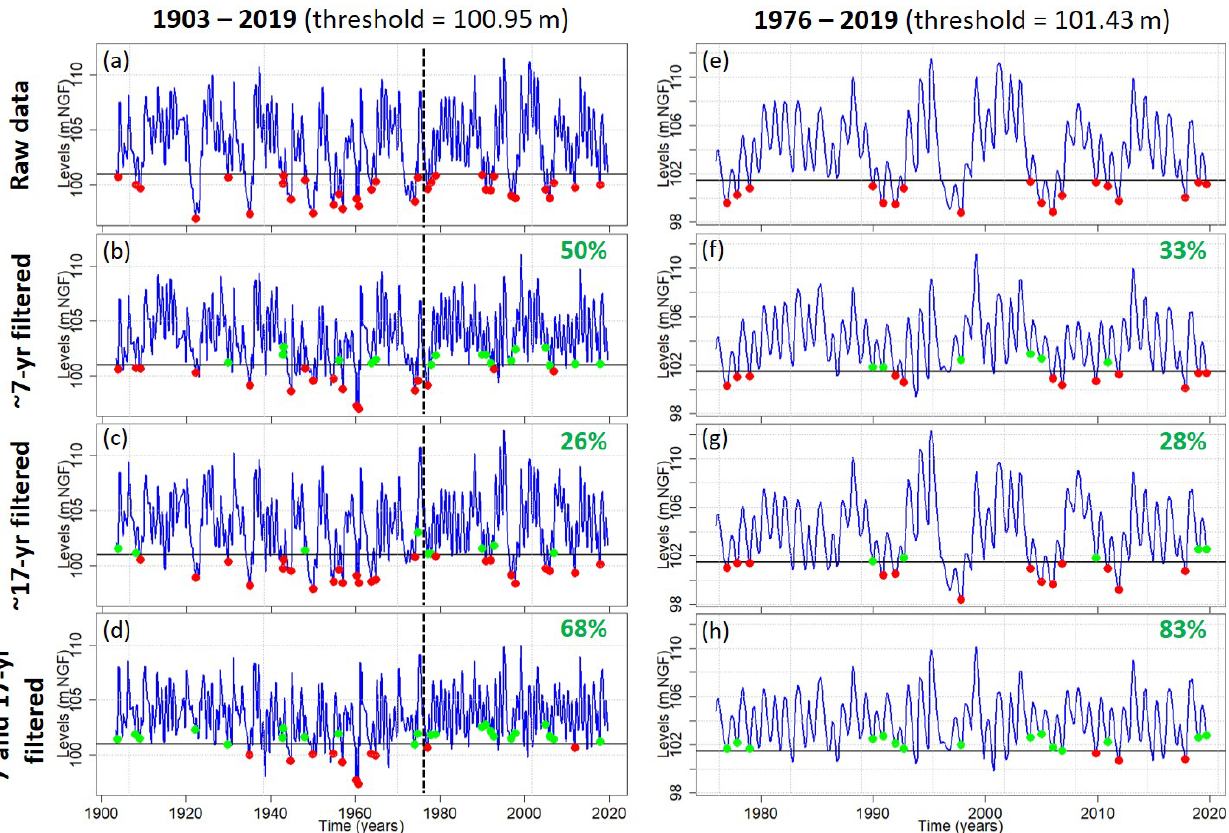
Figure 10. Influence of ∼ 7-year (MAV), ∼ 17-year (DV), and ∼ 7- and ∼ 17-year variabilities on the occurrence of LLs for the Tincques’ GWL over the 1903–2019 and 1976–2019 periods. The percentage of LLs generated by the filtered component(s) (i.e., moving above the percentile 0.2) is indicated in green. The dotted black line represents the year